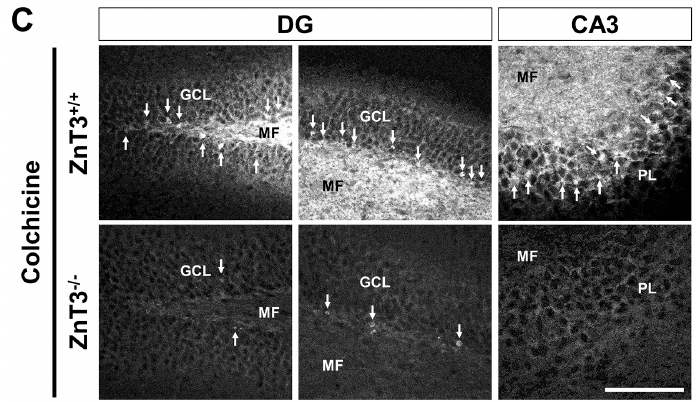
Figure 1. ZnT3 − / − mice exhibit reduced dentate granule cell death after colchicine injection. Brain sections obtained from WT and ZnT3 − / − (KO) mice at 24 h after colchicine injection (WT-colchicine, n = 4; KO-colchicine, n = 5) were analyzed by Fluoro-Jade B (FJB) staining to measure the degree of neurodegeneration. Representative images ( A ) and quantification ( B ) for the degree of neurodegeneration are shown as the number of degenerating cells of dentate gyrus (DG). Scale bar = 50 µ m. Data are the mean ± SEM, * p < 0.05 versus WT mice; ( C ) Fluorescence photomicrographs show zinc-specific TSQ staining in the hippocampal DG and cornus ammonis 3 (CA3) at 24 h after colchicine injection. The dark holes represent the normal appearance of cell bodies, and the bright white fluorescence in the cell bodies (marked by a white arrow) indicates abnormal zinc accumulation. Scale bar = 100 µ m. MF: mossy fiber. GCL: granular cell layer. PL: pyramidal cell layer.